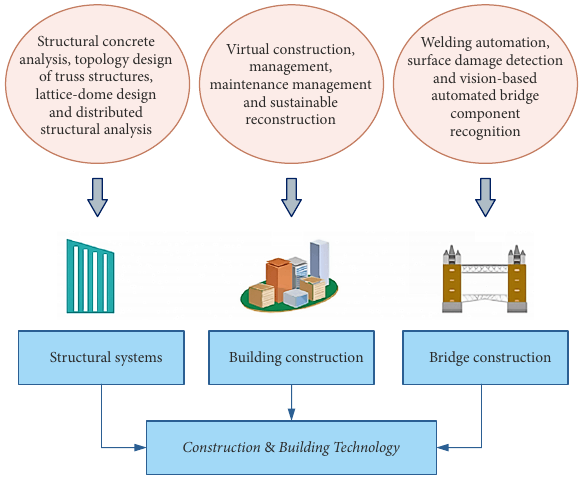
Figure 13. Research topics of Construction